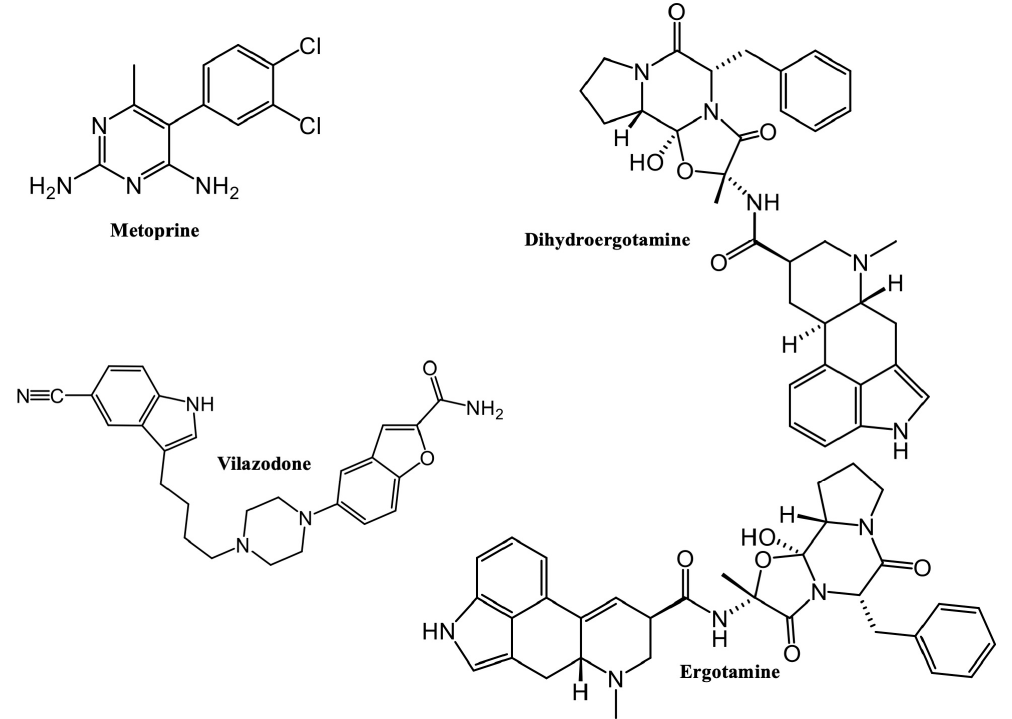
Figure 1. FDA-approved drugs to treat neurological diseases with the highest affinity to HNMT according to docking studies. according to docking